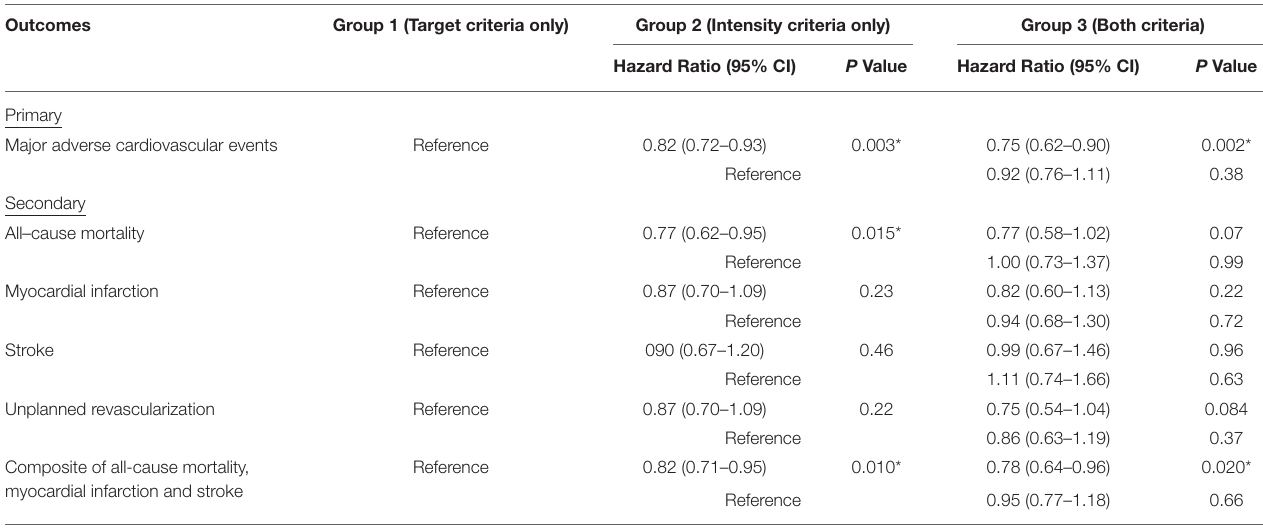
TABLE 4 | Adjusted hazard ratios of primary and secondary